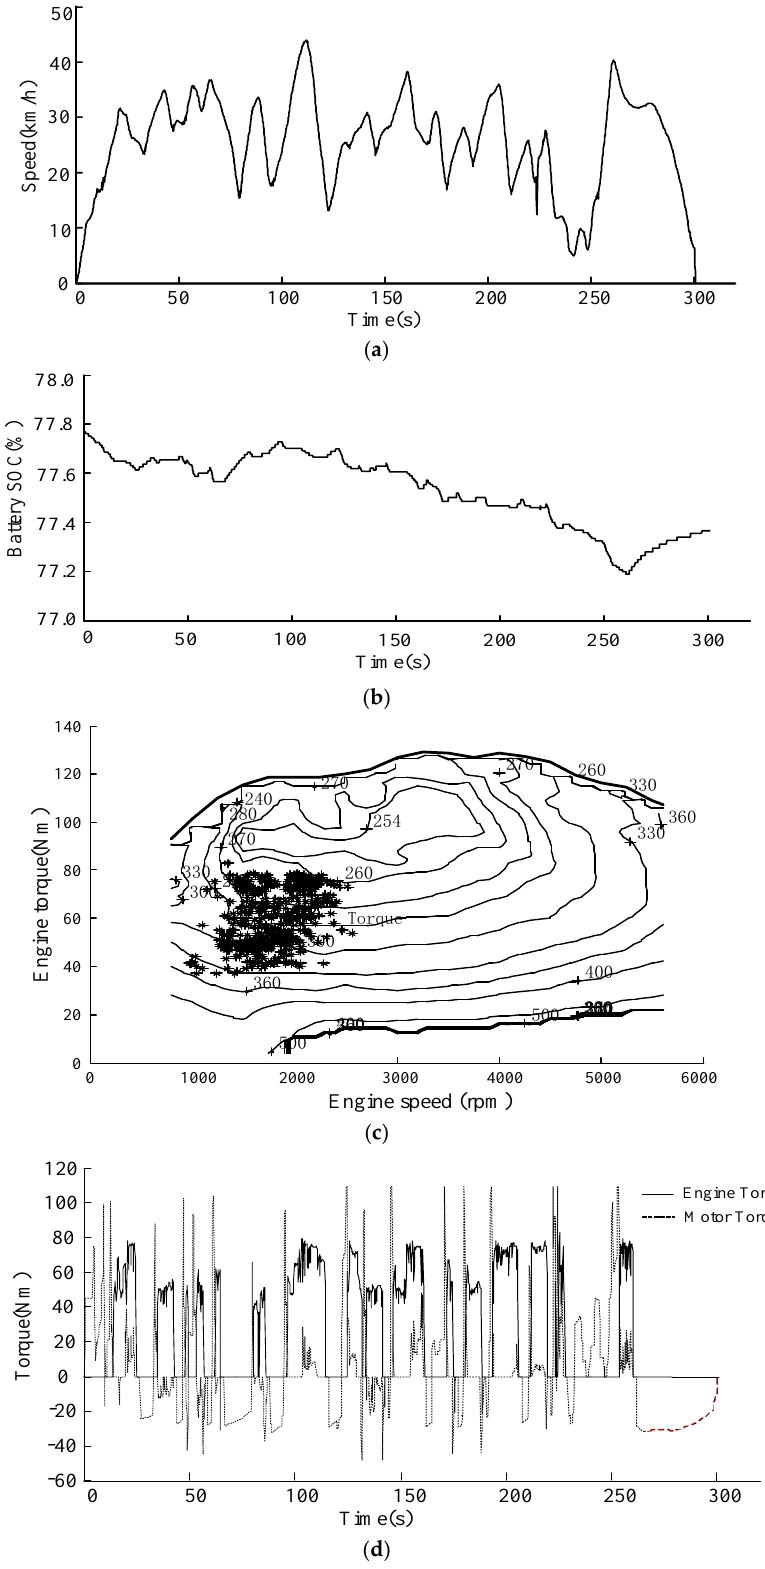
Figure 18. Road test results under the comprehensive driving cycle. ( a ) Time-speed curve of the road test; ( b ) variation of battery SOC ; ( c ) engine operating points during testing; and ( d ) engine and motor toque distribution during testing.